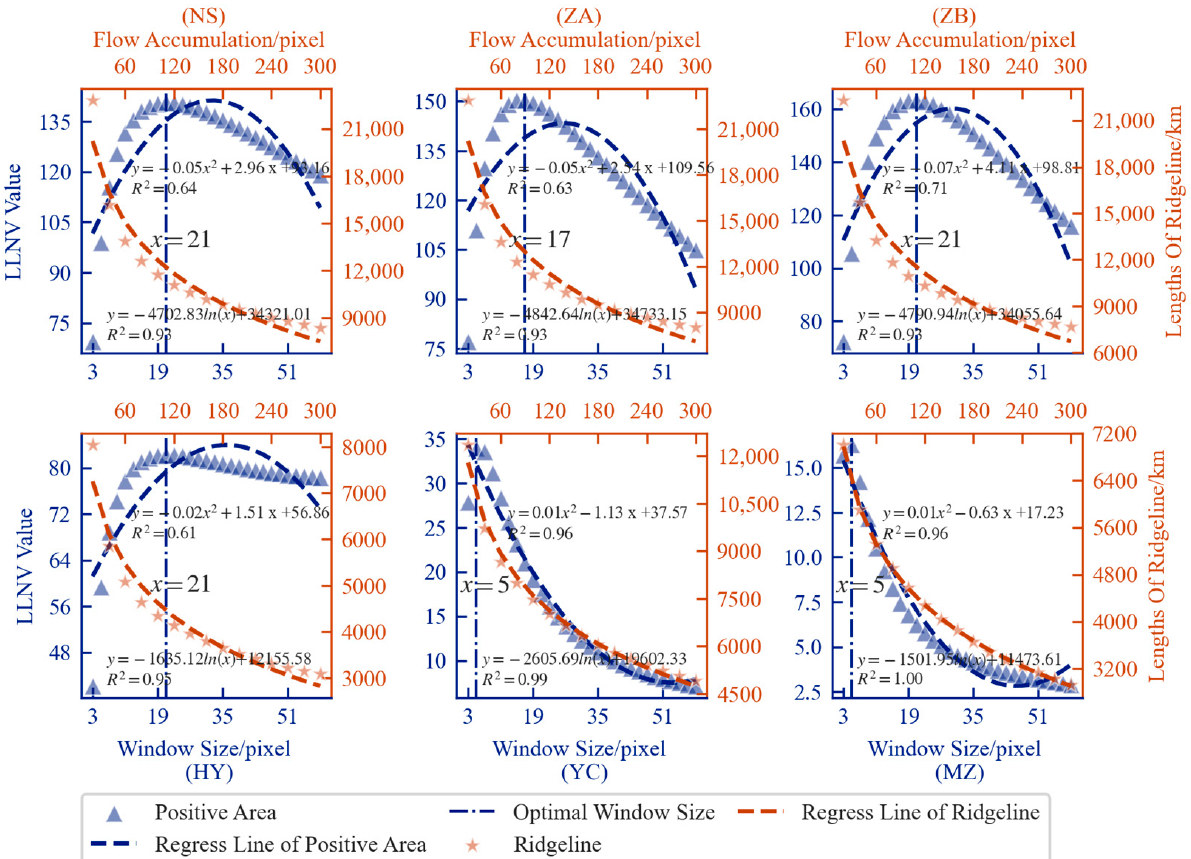
Figure 6. The response of the LLNV and potential ridgelines’ length to changes in the window size of neighborhood analysis and flow accumulation threshold, respectively: the blue triangles represent the response of the LLNV to changes in the window size of the neighborhood analysis, the blue dashed lines represent the quadratic polynomial regression curves of the two, and the blue vertical dashed lines represent the optimal window sizes of the neighborhood analysis obtained by the proposed method. The orange stars represent the response of the extracted ridgeline’s length to changes in flow accumulation thresholds in the runoff simulation, and the orange dashed lines represent the logistic regression curves of the two.